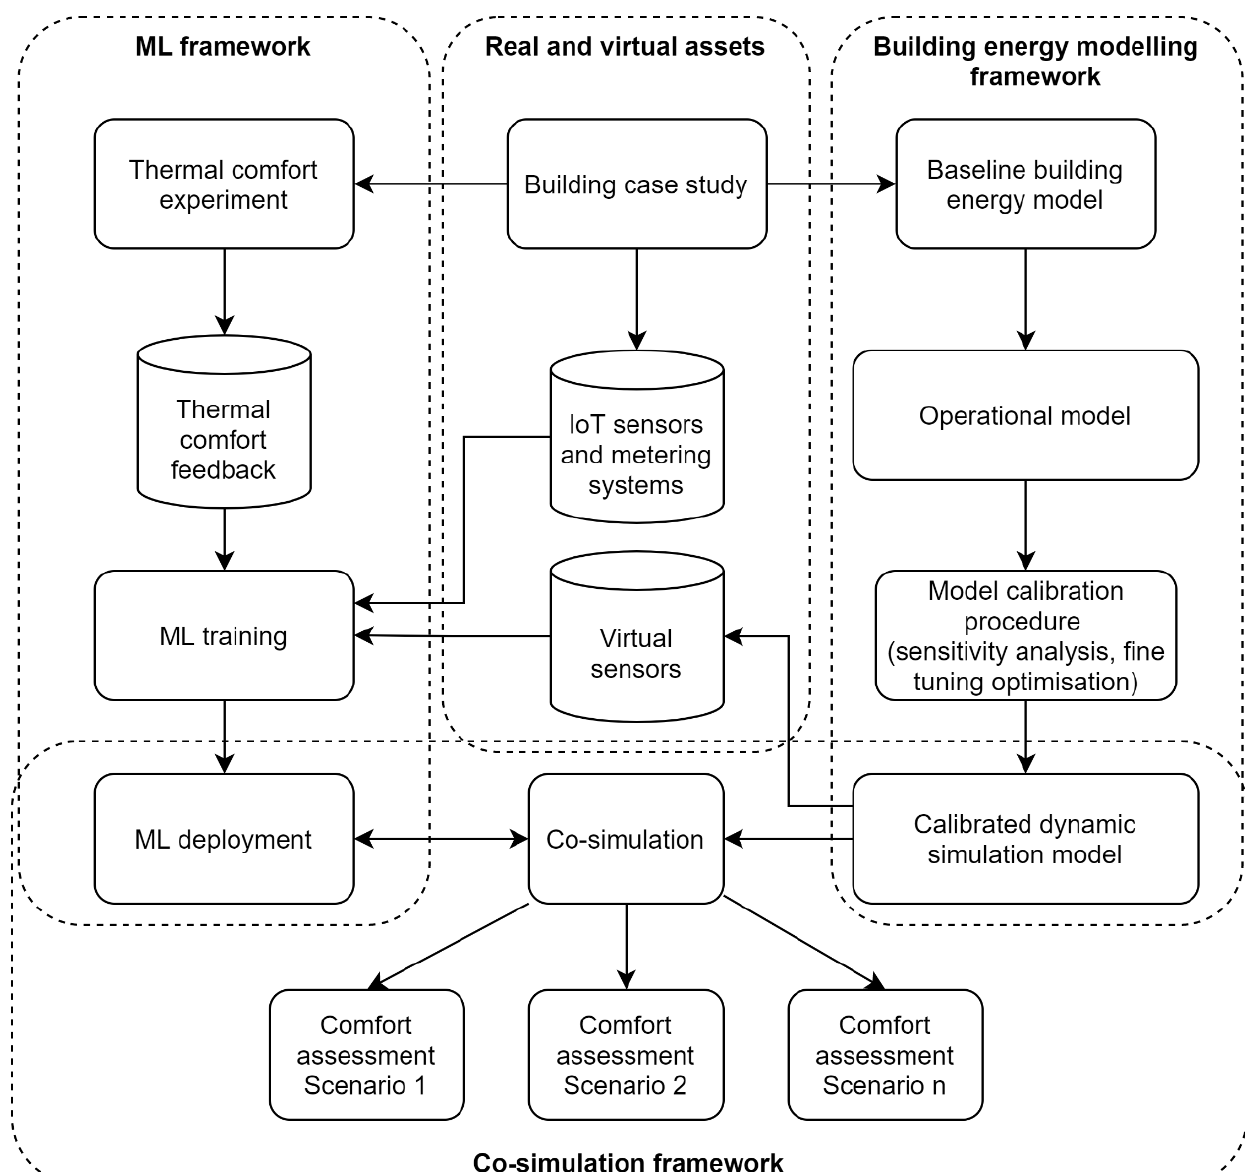
Figure 1. Methodology